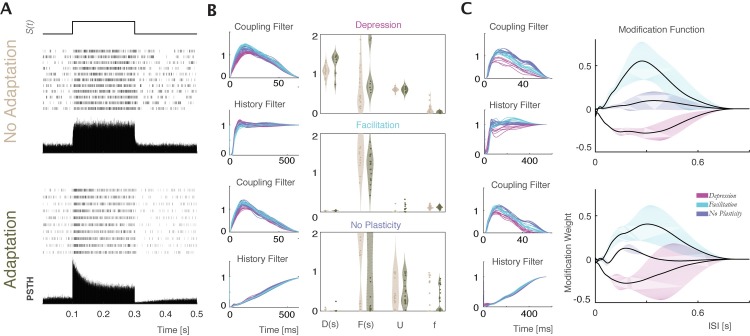
Spike frequency adaptation affects post-spike history filters but does not affect STP estimation.A) Spiking of two LIF model neurons, with and without an IAHP current, in response to a long depolarizing current step. Current step, spike rasters and PSTHs are shown for each model neuron. B) Parameters estimated by the TM-GLM. Estimated coupling filter and post-spike history filter of the two neurons in response to inhomogeneous Poisson inputs with short-time depression (red), facilitation (turquoise), and no plasticity (purple). Violin plots show estimated TM parameters for inputs with each type of the plasticity for the model neurons without (beige) and with IAHP (green). C) GBLM estimates of coupling filter, post-spike history filter, and modification function for depressing (red), facilitating (turquoise), and no plasticity inputs (purple). Solid lines in the right panels show the average modification functions ±1 SD (bands).